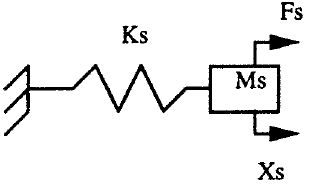
Fig. 3. Single degree of freedom system representing the structure.